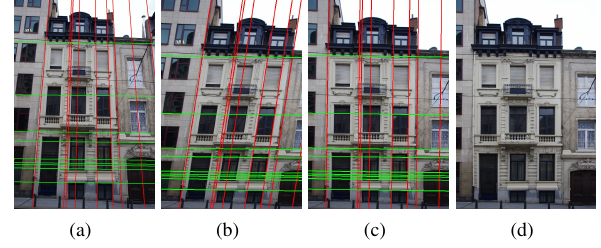
Figure 2: Rectification process: (a) input image with dominant lines, (b) projective distortion removal (c) affine distortion re- moval (d) similarity